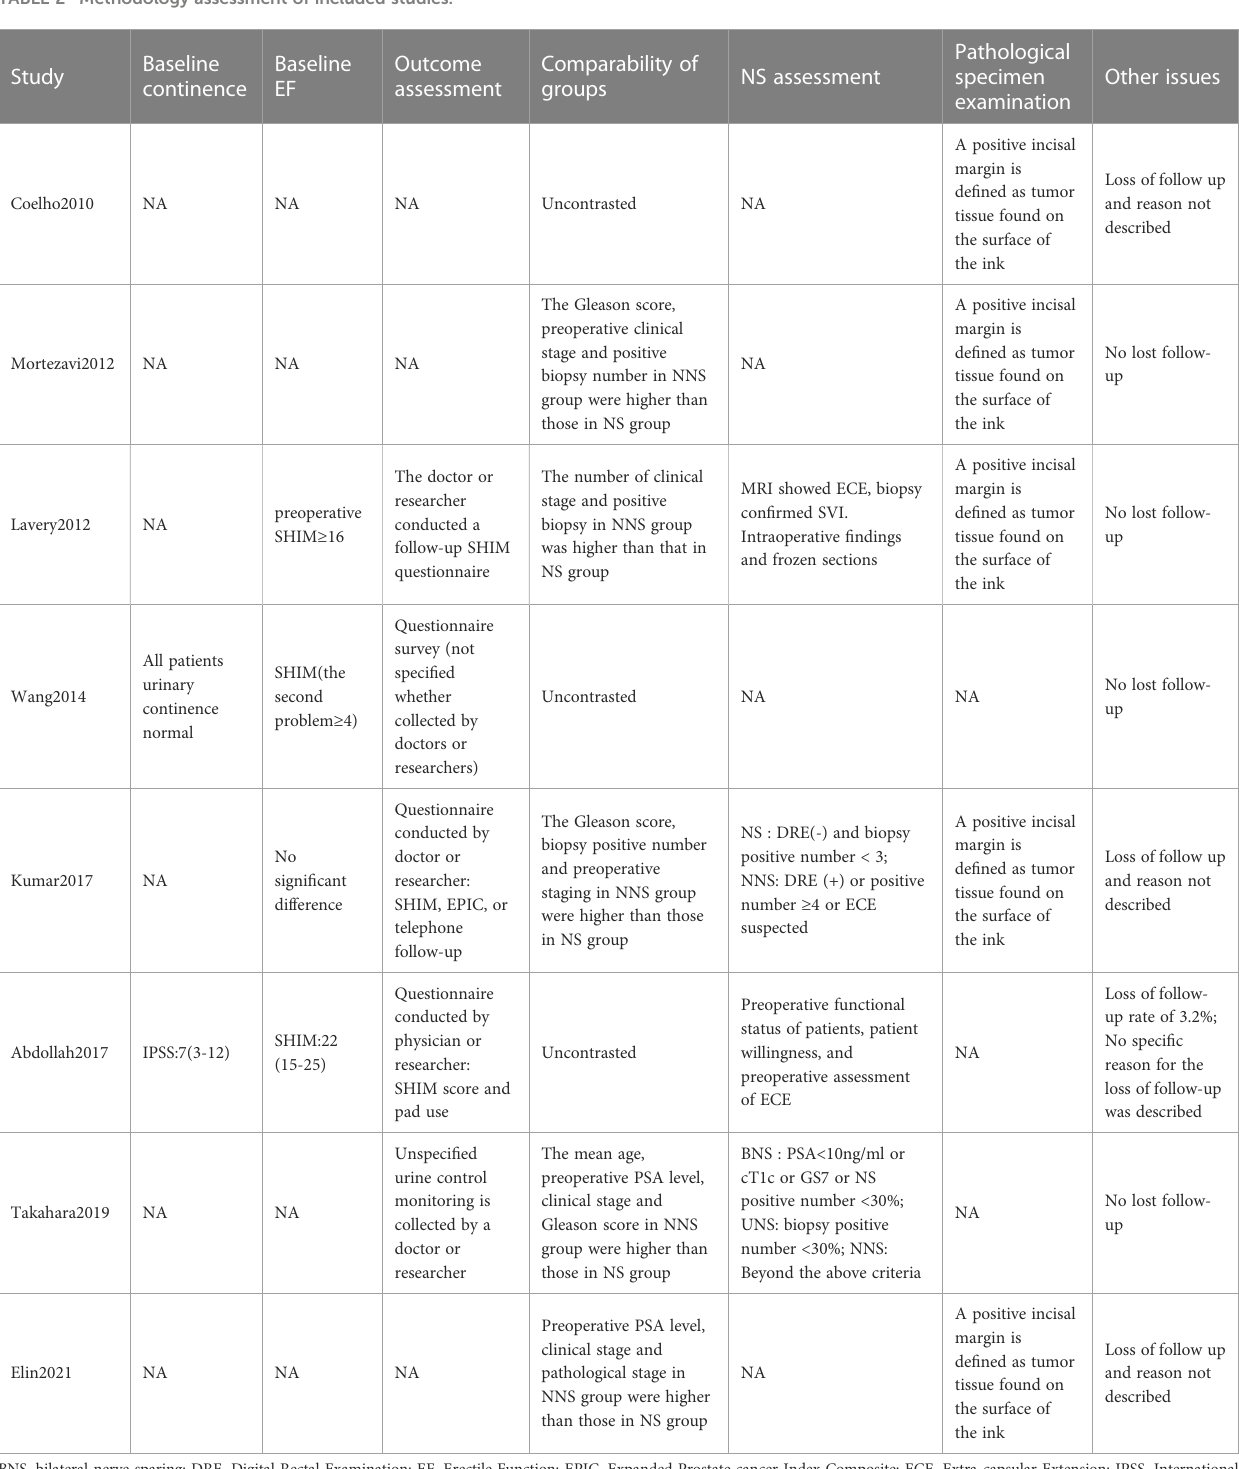
TABLE 2 Methodology assessment of included